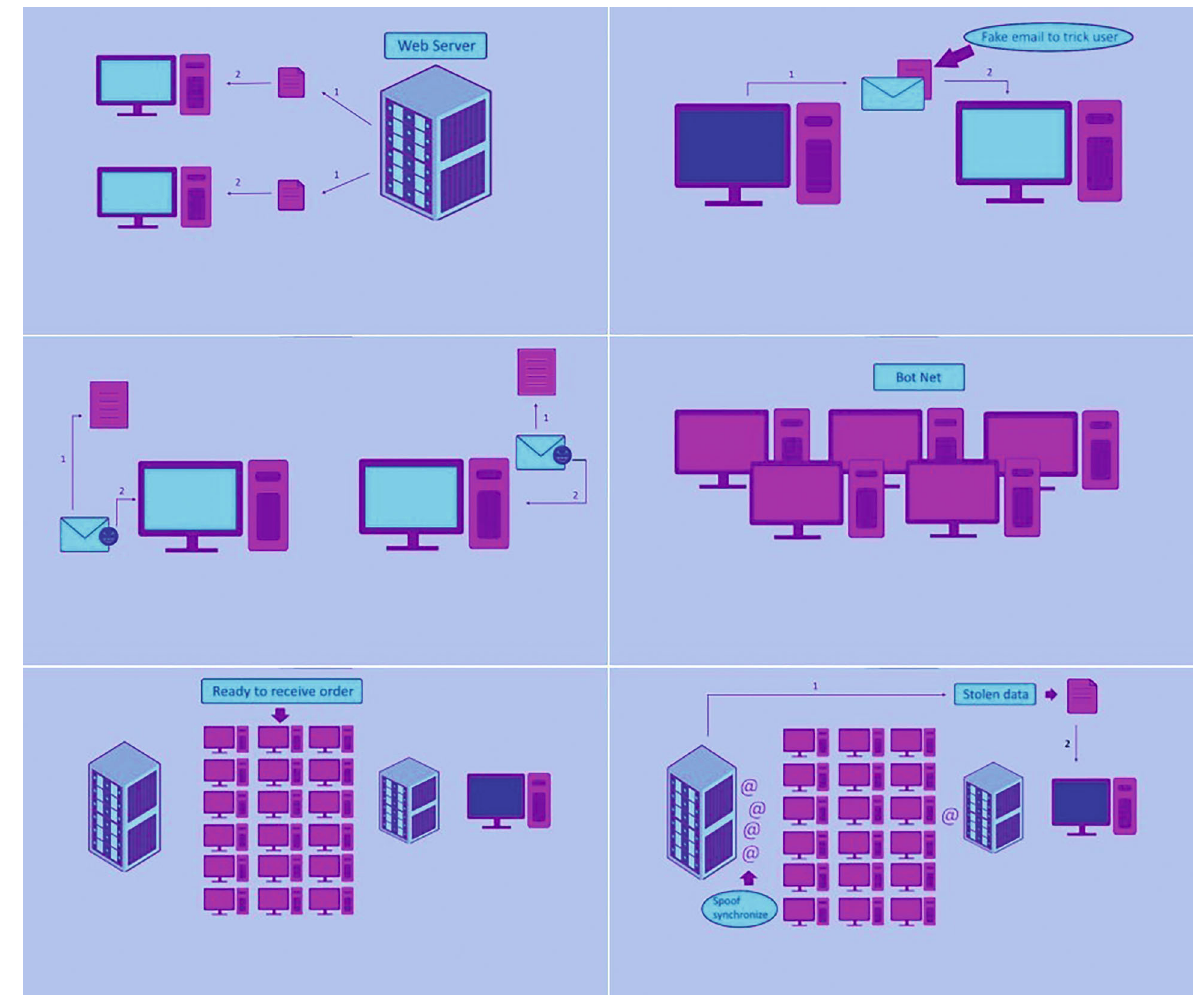
Figure 2: Sample multimedia learning visuals using cold color